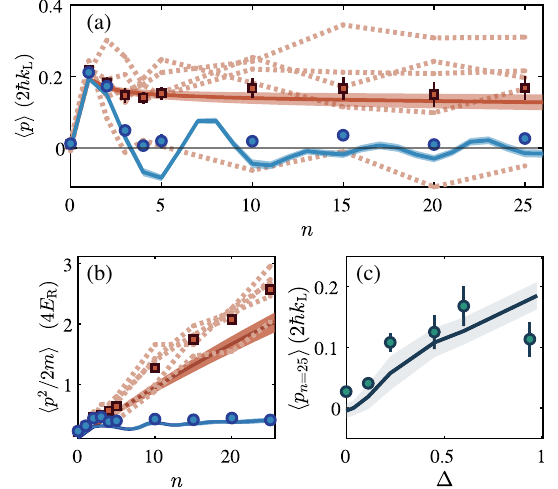
FIG. 4. Destruction of the quantum boomerang effect by stochastic kicking. All error bars correspond to the standard error of the mean for all realizations of randomness. (a) Average momentum measured after n kicks for temporal disorder strength Δ ¼ 0 (blue circles) and Δ ¼ 0 . 6 (red squares). For all data in this figure, T ¼ 8 μ s, α ¼ 0 . 52 , V 0 ¼ 41 E , and the initial condition R was set by an adiabatic lattice load to 8 E . Circles (squares) R represent the mean of measurements with five separate kick disorder realizations for Δ ¼ 0 ( Δ ¼ 0 . 6 ). Dashed lines show individual realizations. Shaded areas in panels (a) and (c) show numerically calculated h p i (cid:2) σ h p i with 9000 disorder realizations and 500 initial quasimomenta. The shaded area in panel (b) in- cludes an additional estimate of the energy accounting for the statistical error in the lattice depth of V 0 ¼ 41 (cid:2) 2 E over 500 R lattice depths and 500 realizations. (b) Measured mean energy for Δ ¼ 0 (blue circles) and Δ ¼ 0 . 6 (red squares) over ten points (blue) and five disorder realizations (red), illustrating the de- struction of dynamical localization by random kicking. (c) Aver- age momentum h p i after 25 kicks versus disorder strength Δ . Dots are averages over ten disorder realizations, except for Δ ¼ 0 , 0.6 (five realizations each). The solid line is numerically calculated h p i over 9000 disorder realizations, with the shaded area showing a 1-standard-deviation